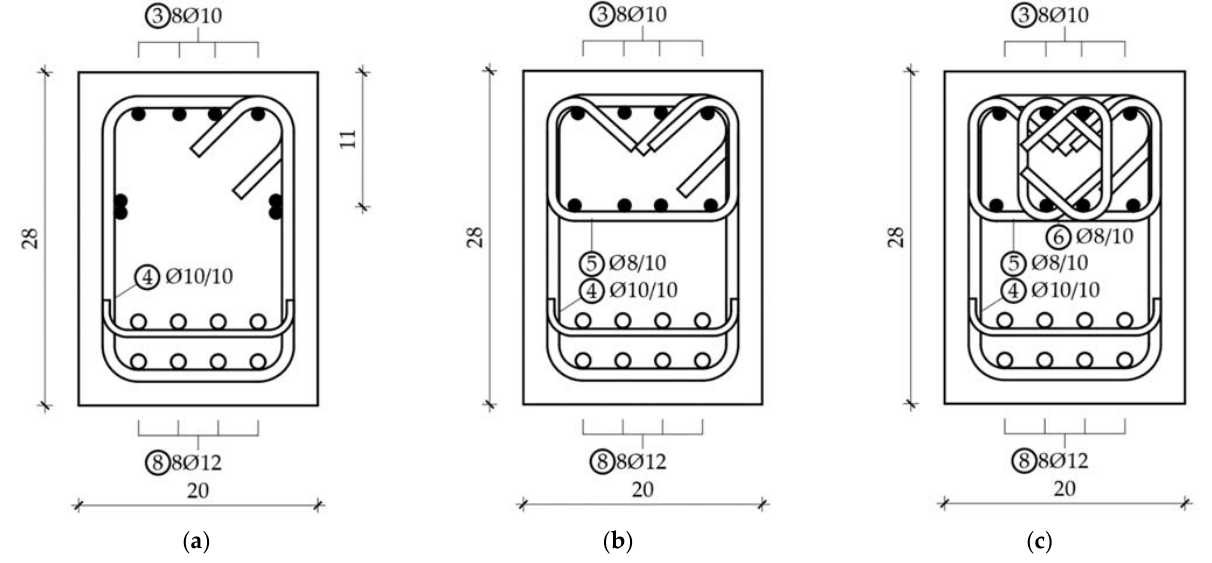
Figure 5. Beam sections: ( a ) Low confinement; ( b ) Medium confinement; ( c ) High confinement. The beam was simply supported with a span of 290 cm loaded with two forces, acting 100 cm from each of the supports. The middle part of the beam, experiencing pure bending, was 90 cm long. The beam was 28 cm high and 20 cm wide. This was the same as the beams in [67]. The difference comes from the internal reinforcement. Internal reinforcement for each of the considered beams is shown in Figure 5.